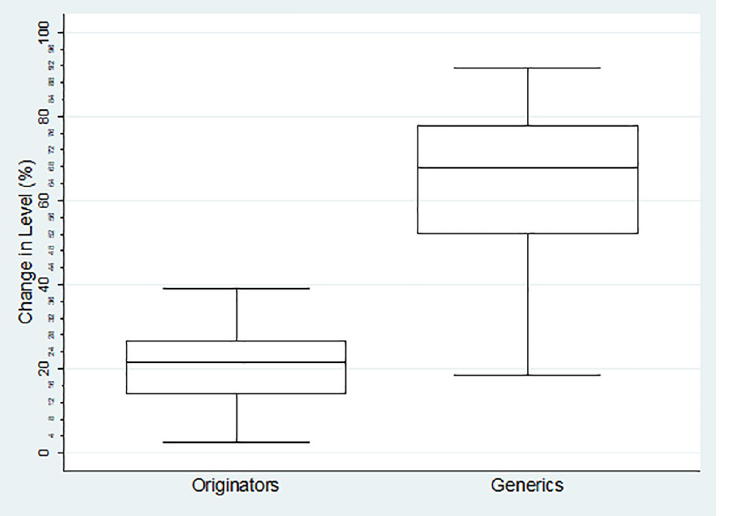
Fig 1. Percentage change in level in the Global Core